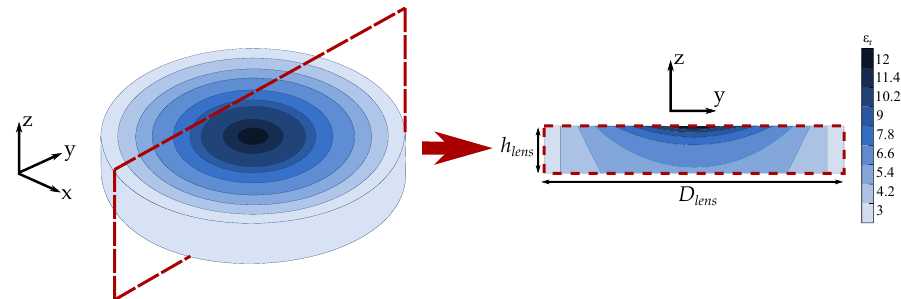
Figure 3. Transformed hyperbolic lens with cut view and section permittivity values.